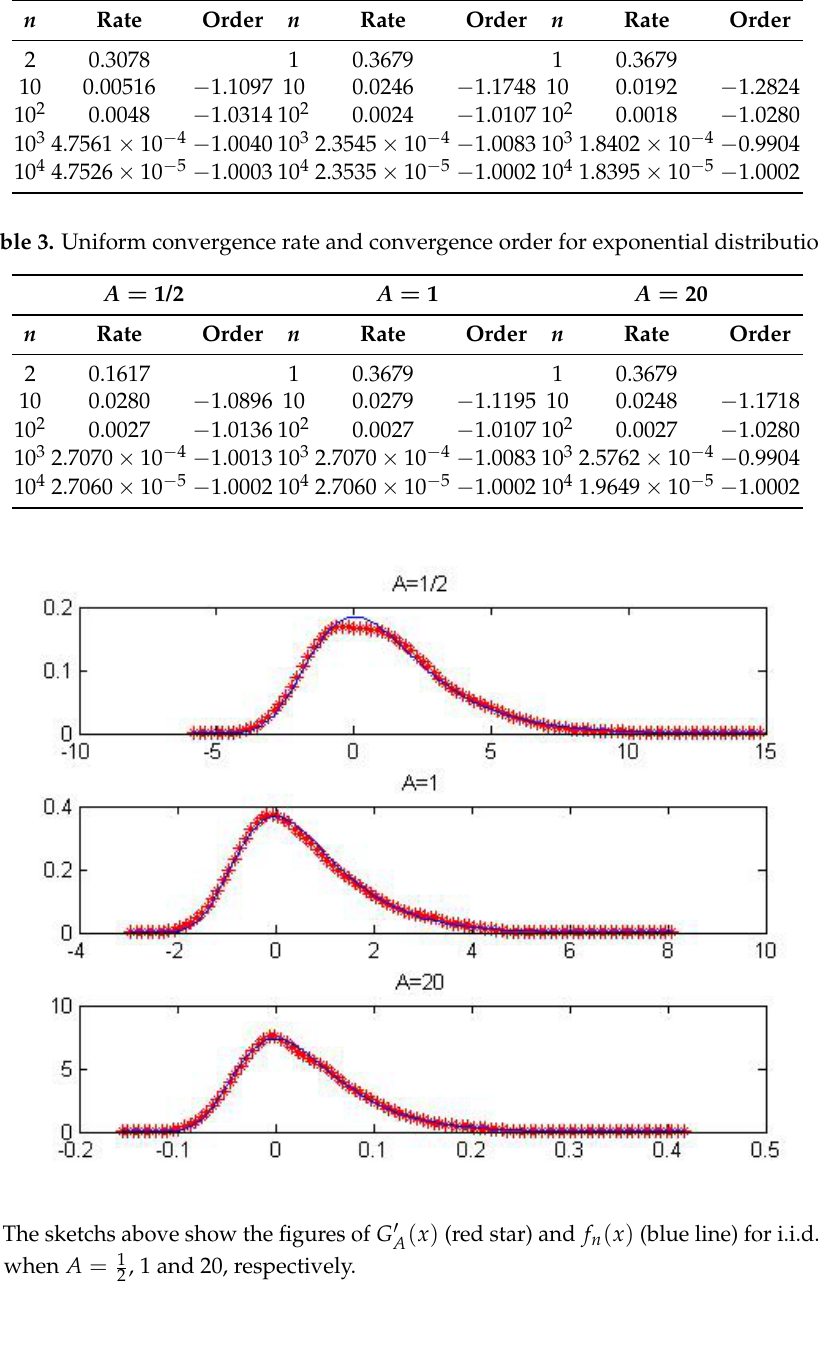
Figure 1. The sketchs above show the figures of G (cid:48) sequence when A = 1 , 1 and 20, 2